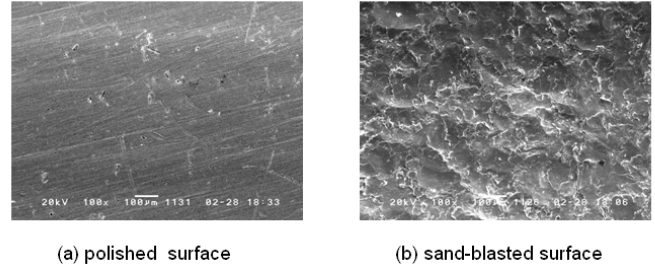
Figure 2. Surface topography of the metal specimens ( a ) polished; ( b ) sand-blasted.